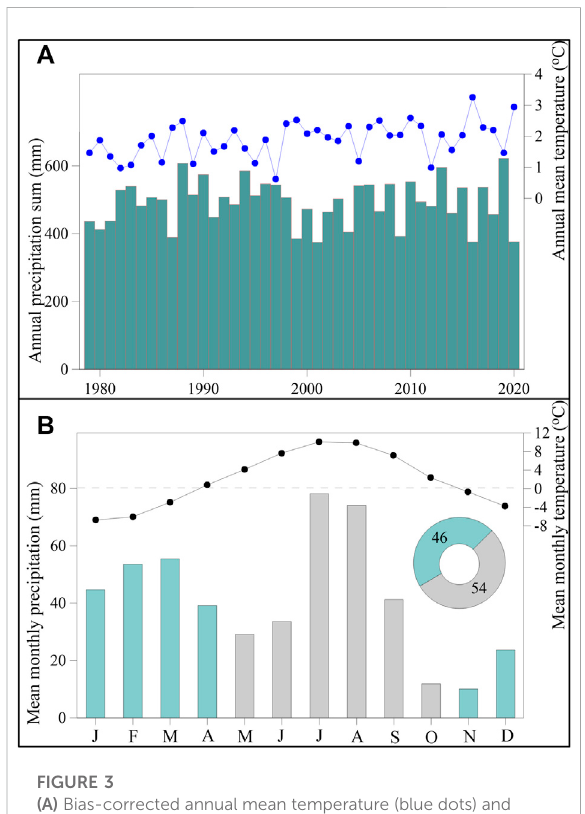
FIGURE 3 (A) Bias-corrected annual mean temperature (blue dots) and annual precipitation sums (green bars) over 1979 – 2020 and (B) bias-corrected mean monthly precipitation and temperature patterns at Bhojbasa Base Camp (black dots represent the temperature, blue-green bars represent the winter precipitation, and the grey bars represent the summer precipitation) and the pie chart inset shows the percent of seasonal precipitation